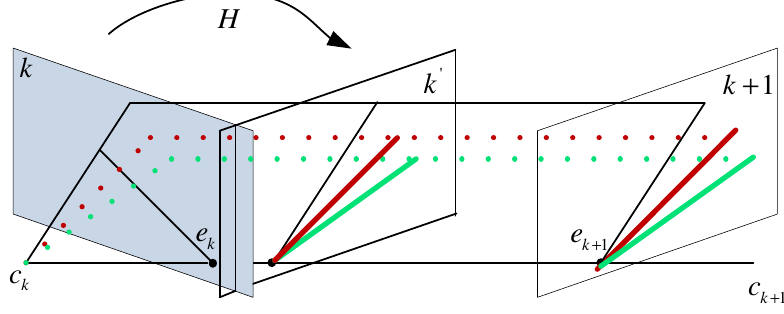
Figure 5. Homography recovery under a general motion of